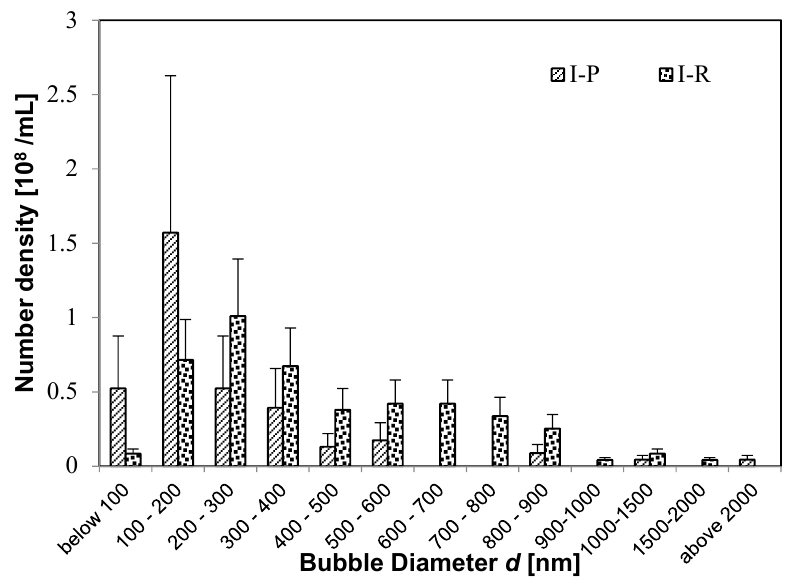
Figure 4. Number of fine bubbles in the UFB-added case before and after reaching plant roots. Before: I-P (thin oblique line). After: I-R (thick points).